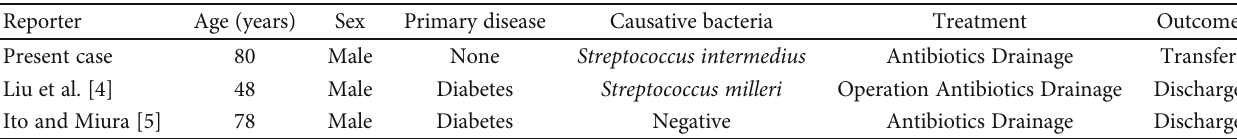
Table 2: The comparison of three cases.